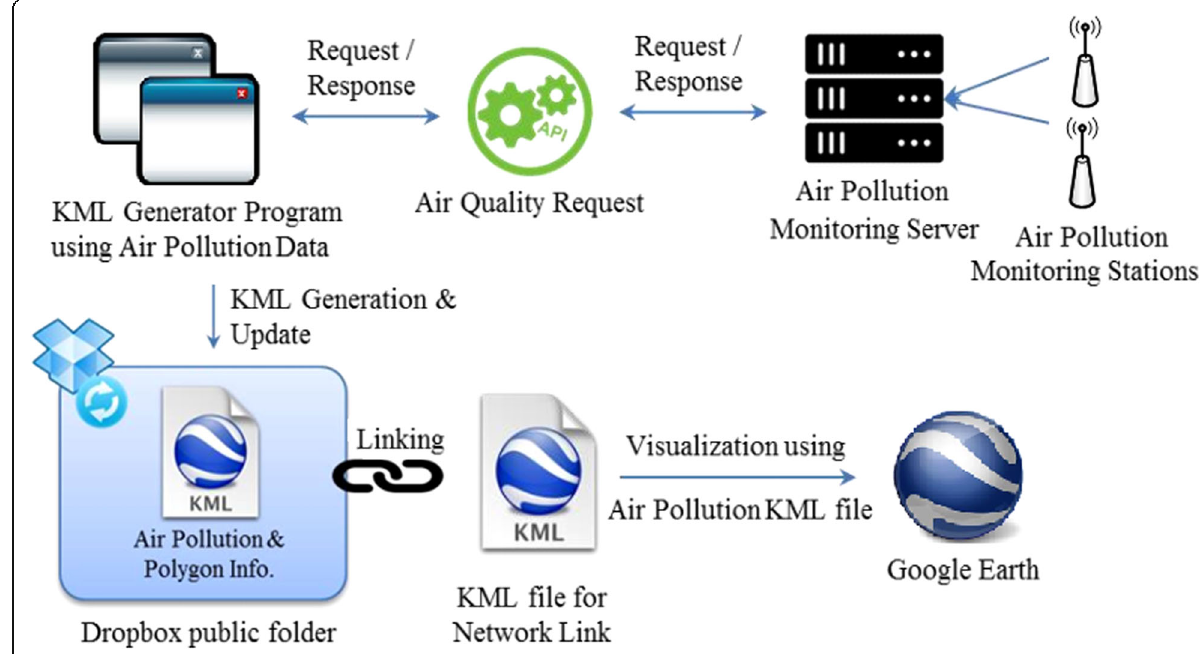
Fig. 4 Process of reading air quality data and data